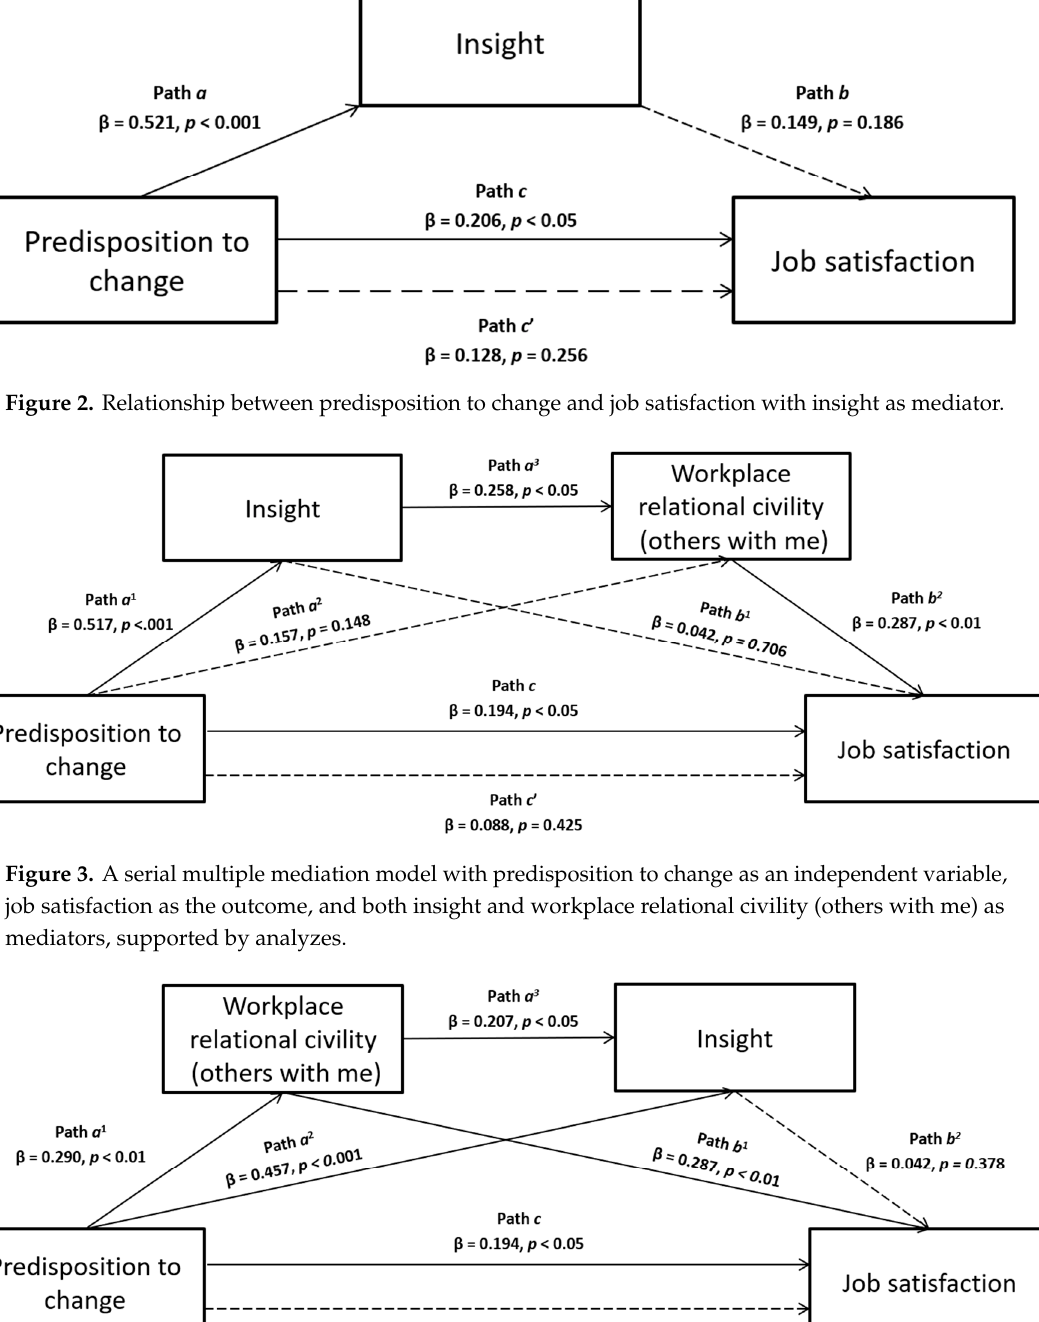
Figure 2. Relationship between predisposition to change and job satisfaction with insight as mediator